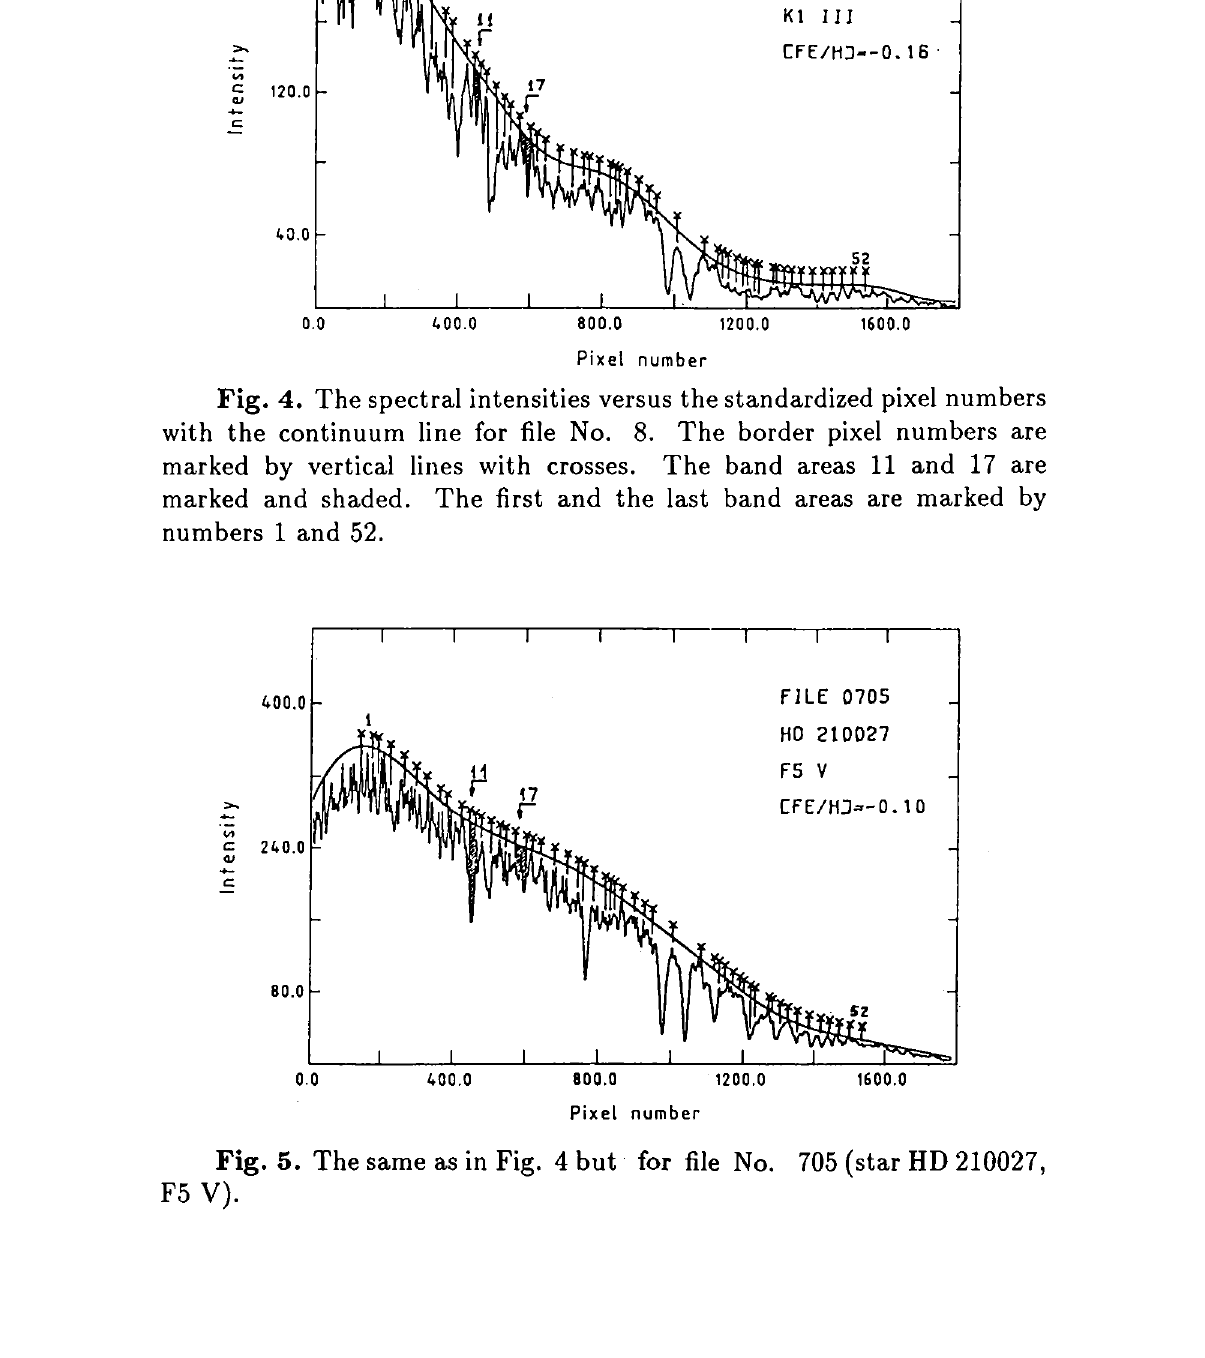
Fig. 5. The same as in Fig. 4 but for file No. 705 (star HD 210027, F5